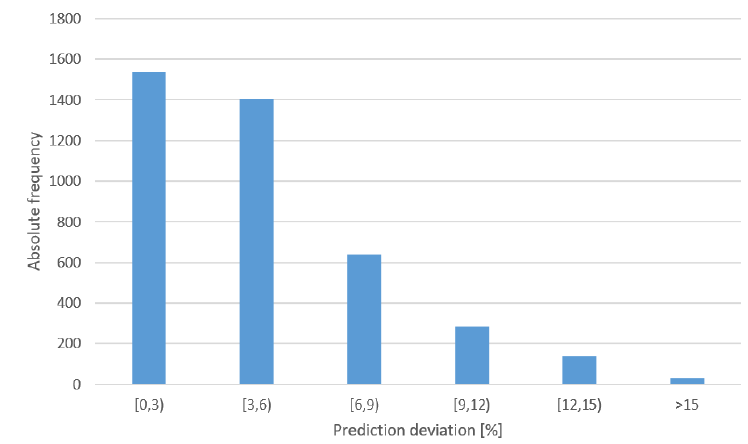
Figure 10. Histogram of the prediction error of the yield strength for all